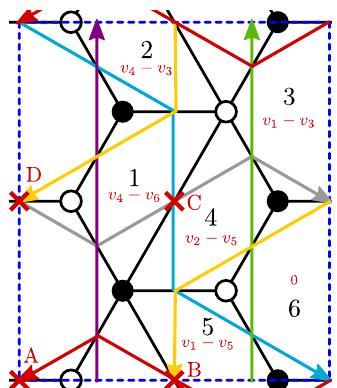
Figure 12. Dimer diagram for PdP 3 b with fixed points. We show the ZZPs and the rank assign- ments coming from